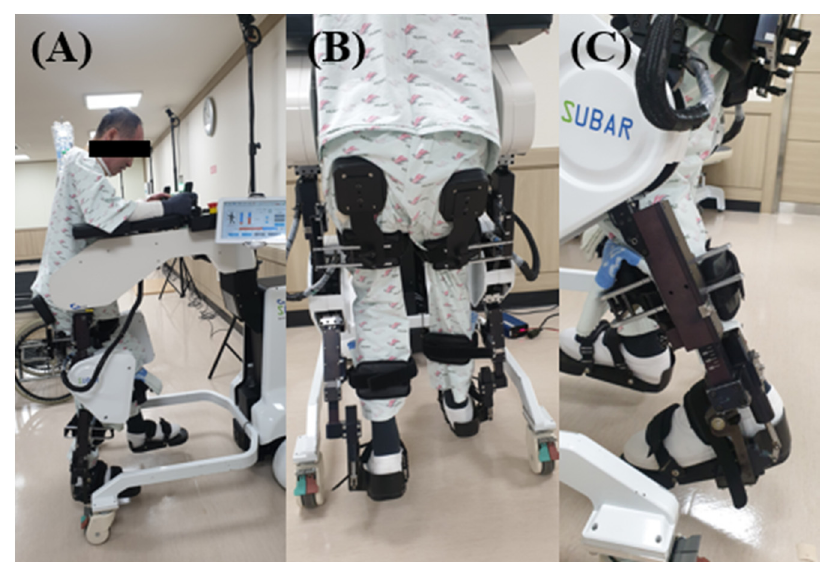
Figure 3. ( A ) SUBAR ® (CRETEM, Korea), an exoskeletal-type gait training robot; ( B ) a patient participating in gait training using the SUBAR ® from behind; ( C ) foot plate.